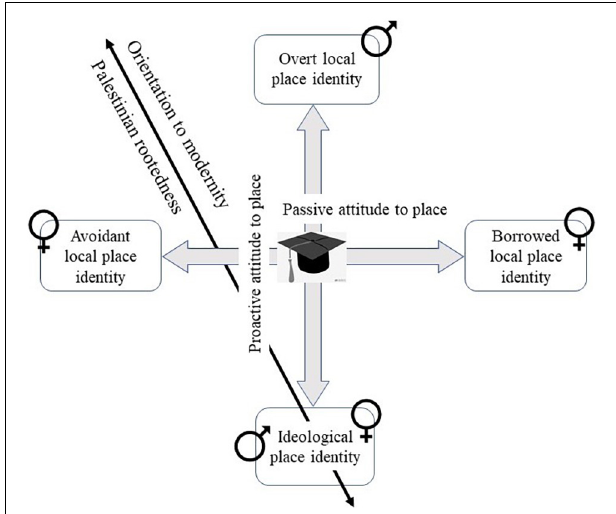
FIGURE 1 | Strategy formation of place identity on